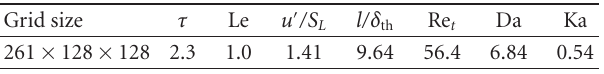
Table 1: List of initial values of turbulence and combustion pa- rameters for the present DNS